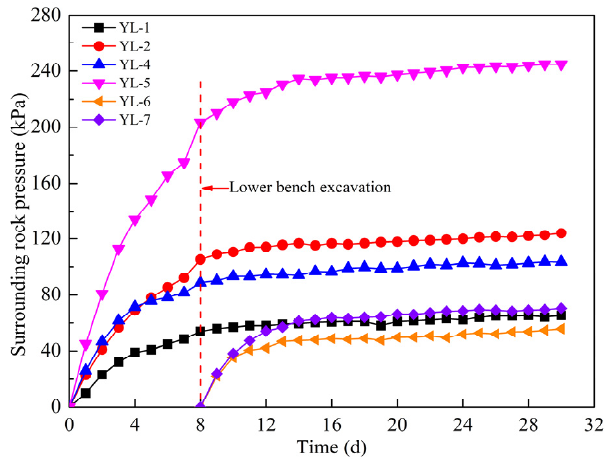
Figure 26. Duration curves of the surrounding rock pressure.